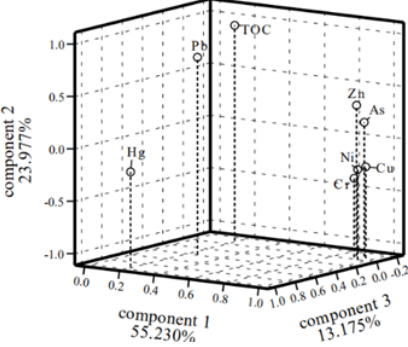
Figure 4. Three-dimensional spatial load graph of heavy metal and total organic carbon (TOC) in the sediment of the Shuanglong reservoir. Table 3. Results of the correlation analysis among the heavy metals and other indicators in the sediment of the Shuanglong reservoir.